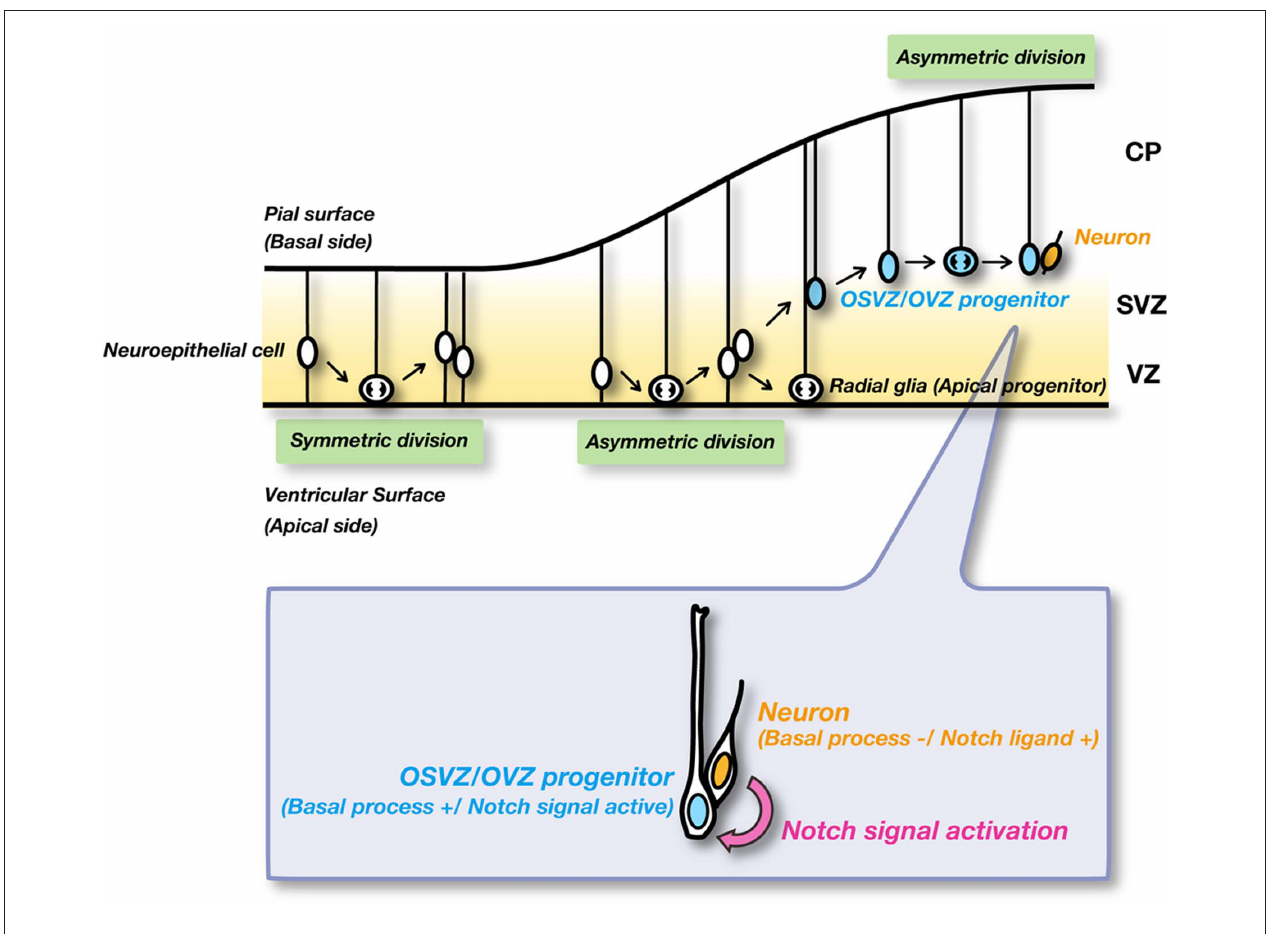
Figure 6 | Notch signaling in OSVZ/OVZ progenitors. OSVZ/OVZ progenitors have radial glia-like morphology and extend radial fibers to the pial surface, but lack apical processes. These cells undergo asymmetric cell division